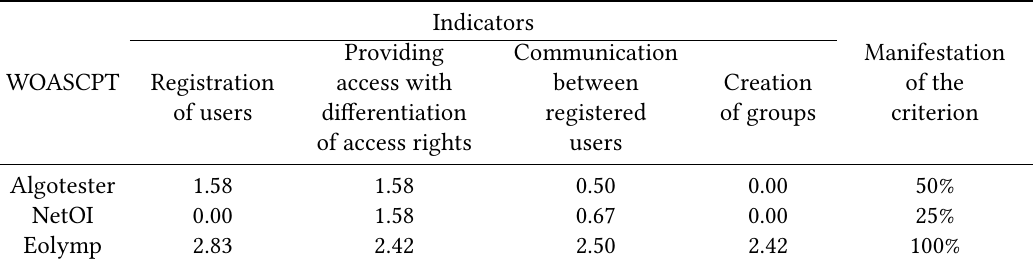
Table 5 Communication criterion for web-oriented automated systems for checking programming tasks and its